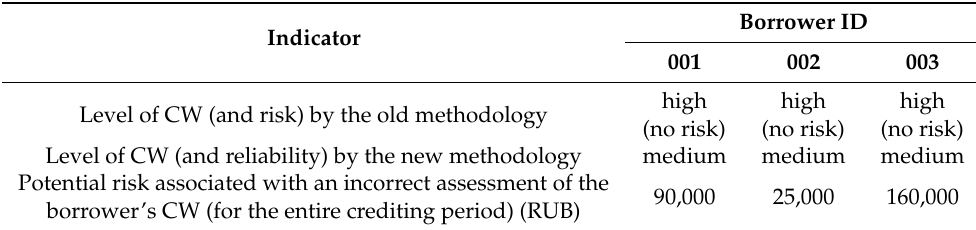
Borrower ID 001 002 003 high high high (no risk) (no risk) (no risk) 90,000 25,000